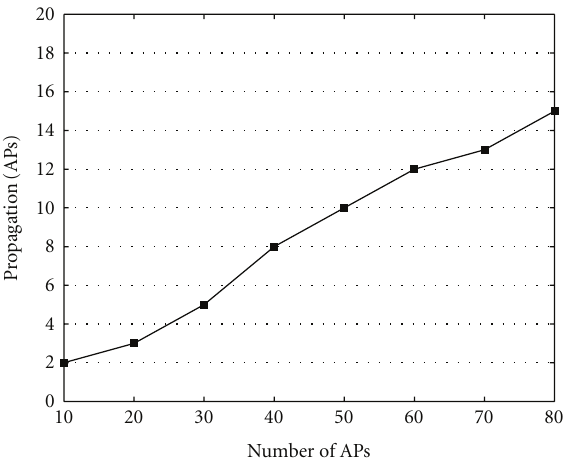
Figure 16: Propagation e ff ect when the AP that “fires” the execution of LAC is placed at random of the